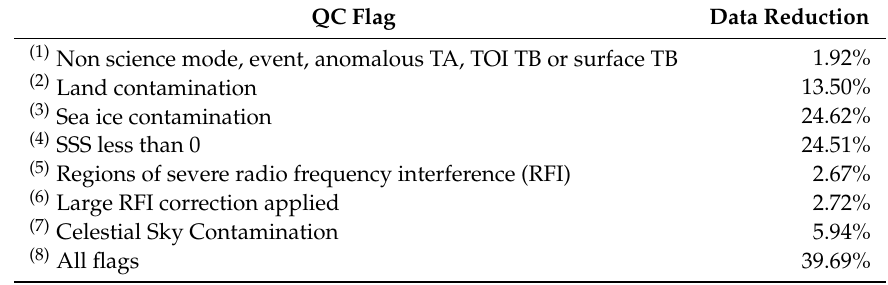
Table 1. Reduction in the amount of Aquarius L2 samples over ocean due to filtering based on quality control